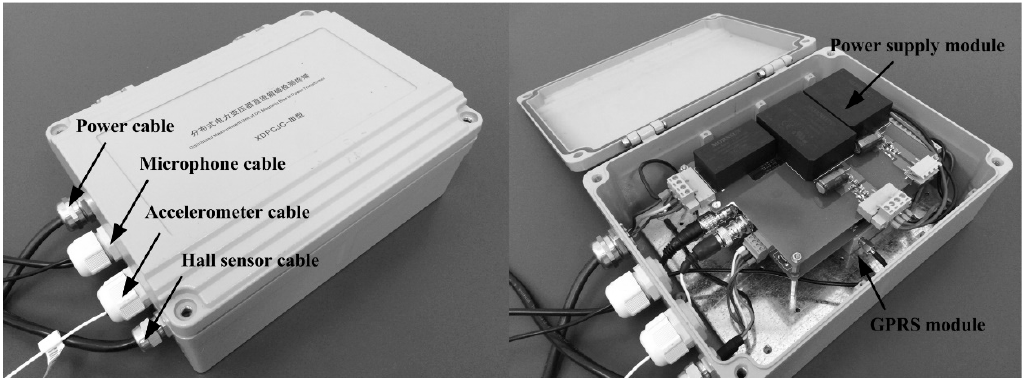
Figure 11. Photograph of the on-line monitoring device.